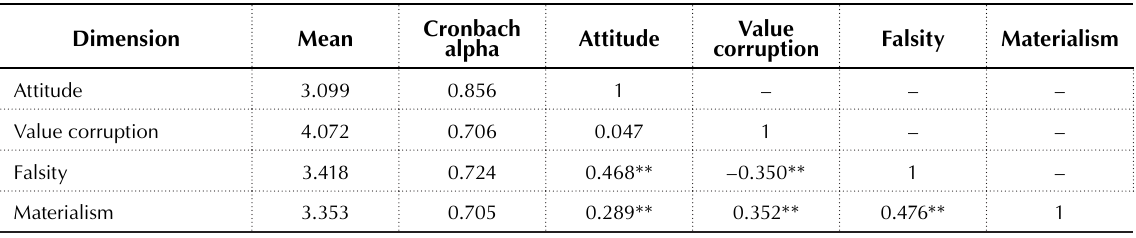
Table 1. Correlations for the belief toward advertising